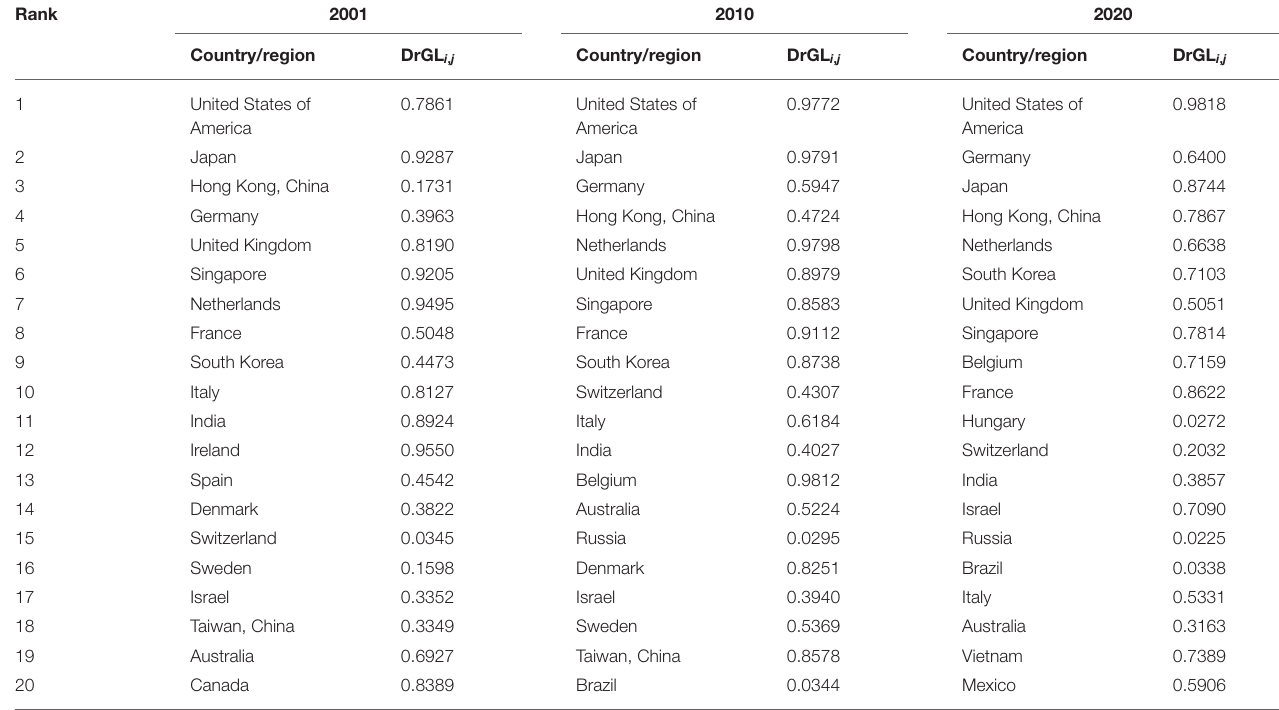
TABLE 7 | Interdependence between China and its top 20 trading partners for medical devices in 2001, 2010, and 2020.